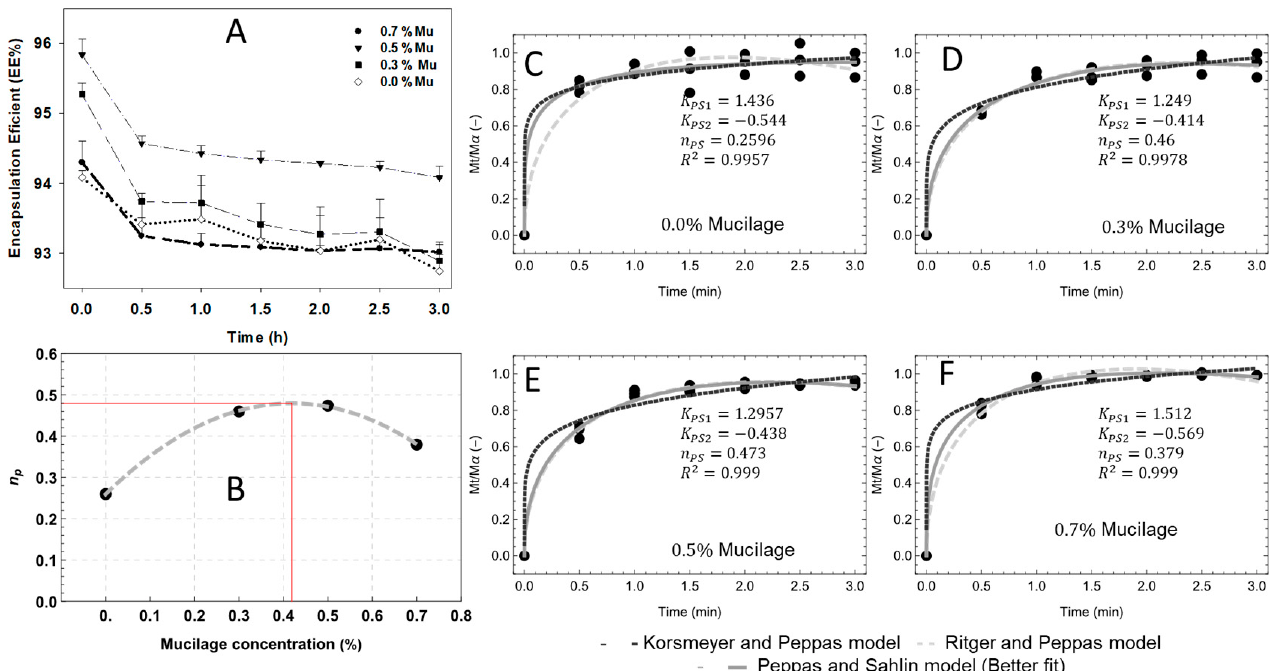
Figure 3. ( A ) Kinetic of entrapment efficiency (EE%) of rhodamine B at different mucilage concen- trations; ( B ) optimal mucilage concentration in function of exponent “ n ”; ( C – F ) release profile of rhodamine B fitted to the Peppas and Sahlin model. M t and M α represent the amount of rhodamine B released at time “t” and at infinite time “ α ”, respectively.